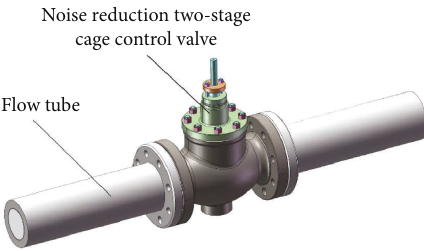
Figure 23: Calculation model of cavitation